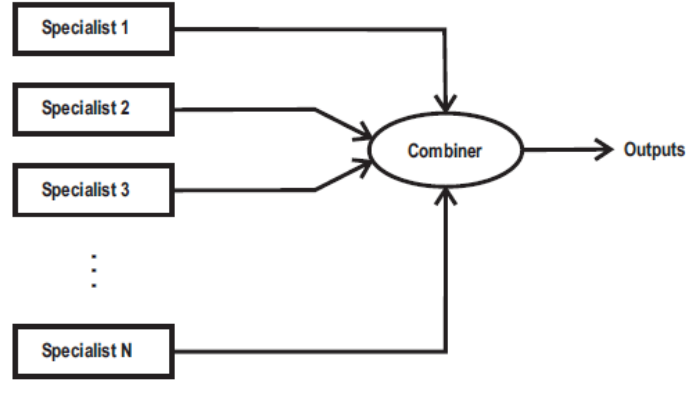
Figure 4. Schematic of an ensemble.